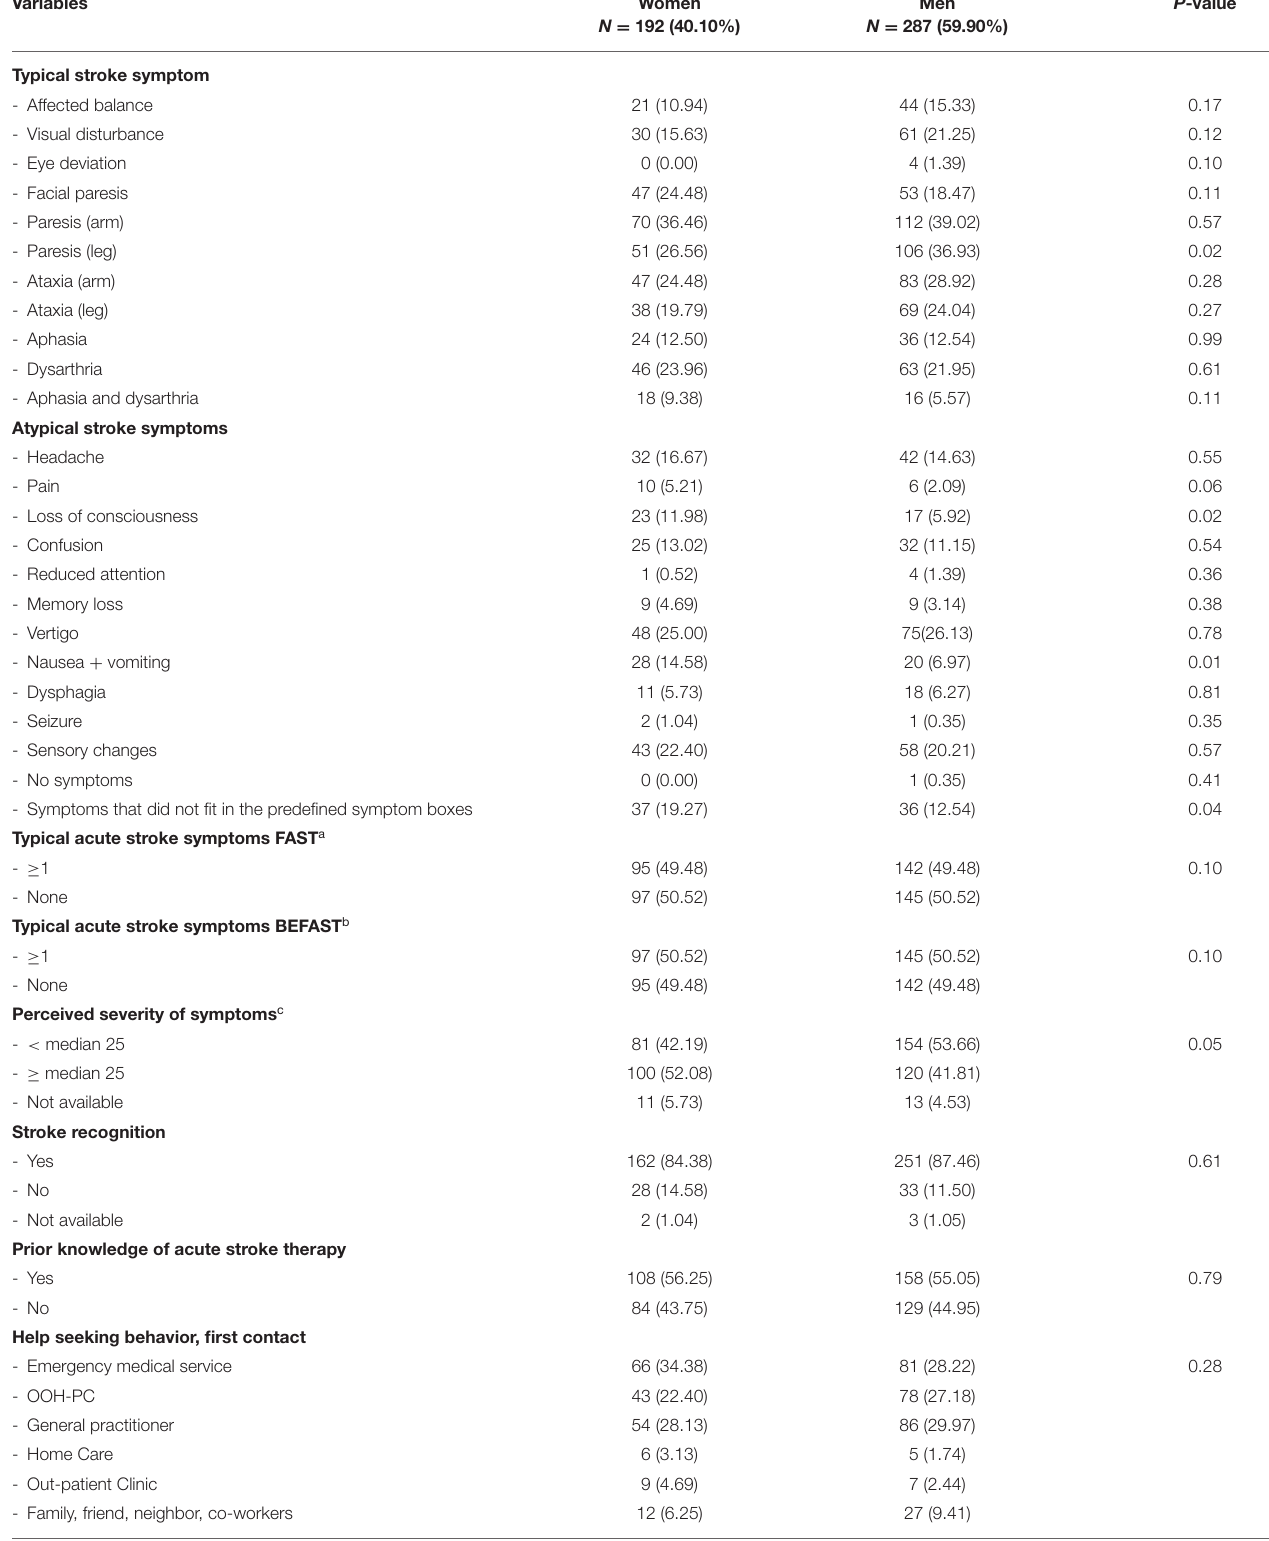
TABLE 2 | Patient-reported symptoms, stroke knowledge, behavioral response, arrival time, and treatment. Variables Women